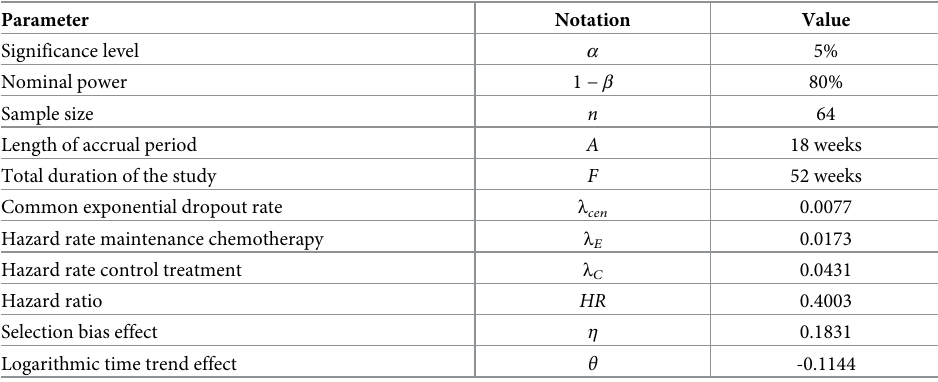
Table 2. Setting of the AML